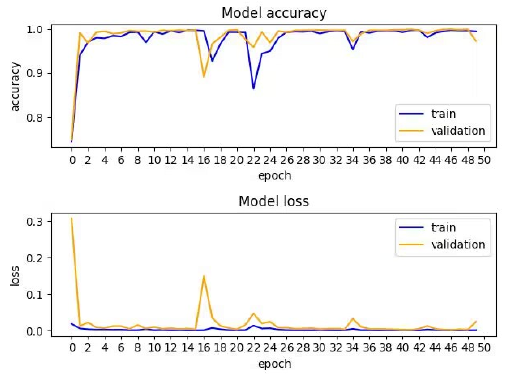
Figure 11. Accuracy loss curve of SE-Res2Net-CBAM-BiLSTM model.